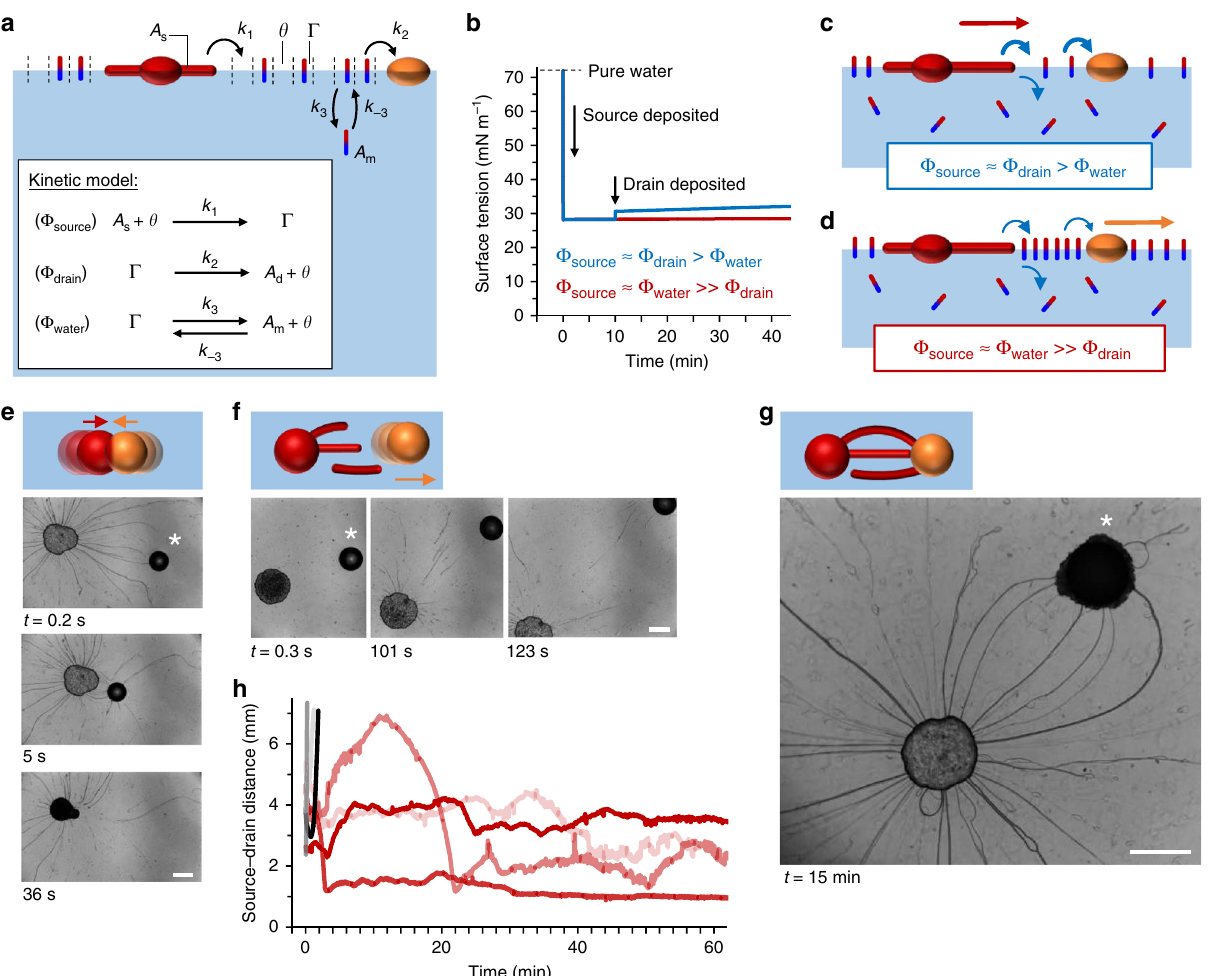
Fig. 2 Droplet positioning relies on balanced rates of amphiphile release, depletion, and fi lament absorption. a Kinetic model, describing Φ source , the release of amphiphiles from the source droplet (red sphere) to the air – water interface; Φ drain , the depletion of amphiphiles from the air – water interface to the drain droplet (orange sphere), and Φ water , the depletion of amphiphiles from the air – water interface to the underlying aqueous phase (blue). b Simulations of surface tension kinetics upon deposition of the source and drain droplets. The surface tension increases only if the uptake of amphiphiles at the drain is faster than the depletion towards the underlying aqueous phase (blue curve). c If Φ source ≈ Φ drain > Φ water , the Marangoni fl ow is dominated by depletion at the drain. d If Φ source ≈ Φ water ≫ Φ drain , the Marangoni fl ow is dominated by depletion towards the underlying aqueous phase. e In the drain- dominated regime 1, a strong Marangoni fl ow emerged from the source droplet towards the drain (deposited at t = 0 s, indicated with an asterisk), and the drain merged with the source droplet. f In regime 2, the Marangoni fl ow was dominated by depletion towards the underlying aqueous phase and pushed the drain (deposited at t = 0 s) away from the source (deposited at t = − 34.5 s). g In regime 3, the fi laments were absorbed by the drain droplet, such that the drain was kept in position — despite the repulsive forces of the Marangoni fl ow. h Time-dependent center-to-center source – drain distance: the black and gray curves correspond to the experiments shown in f and Supplementary Fig. 5; the red curves to the experiments shown in g and Supplementary Fig. 6. The scale bars represent 1